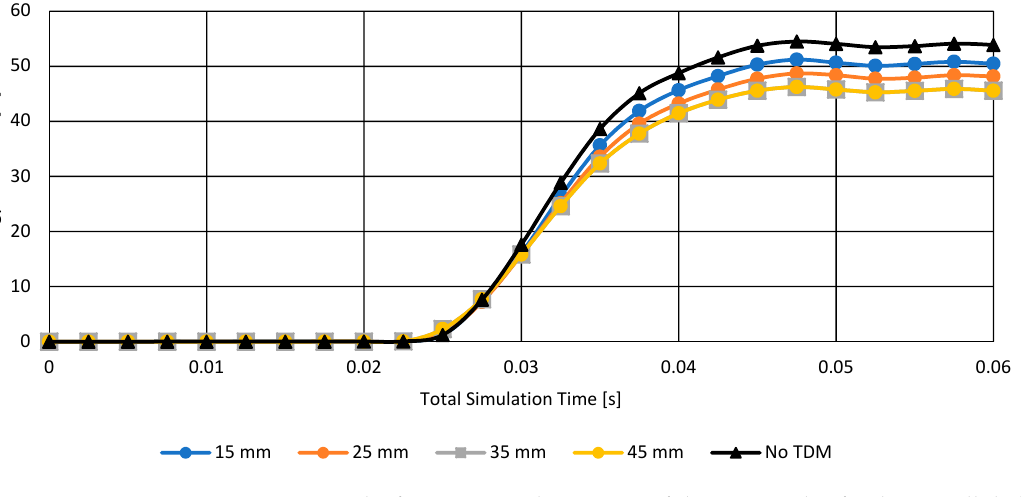
Figure 7. FEA results of energy absorptions of a vehicle after colliding on a street pole (frontal col- lision scenario) using five different thicknesses of TDM shielding.